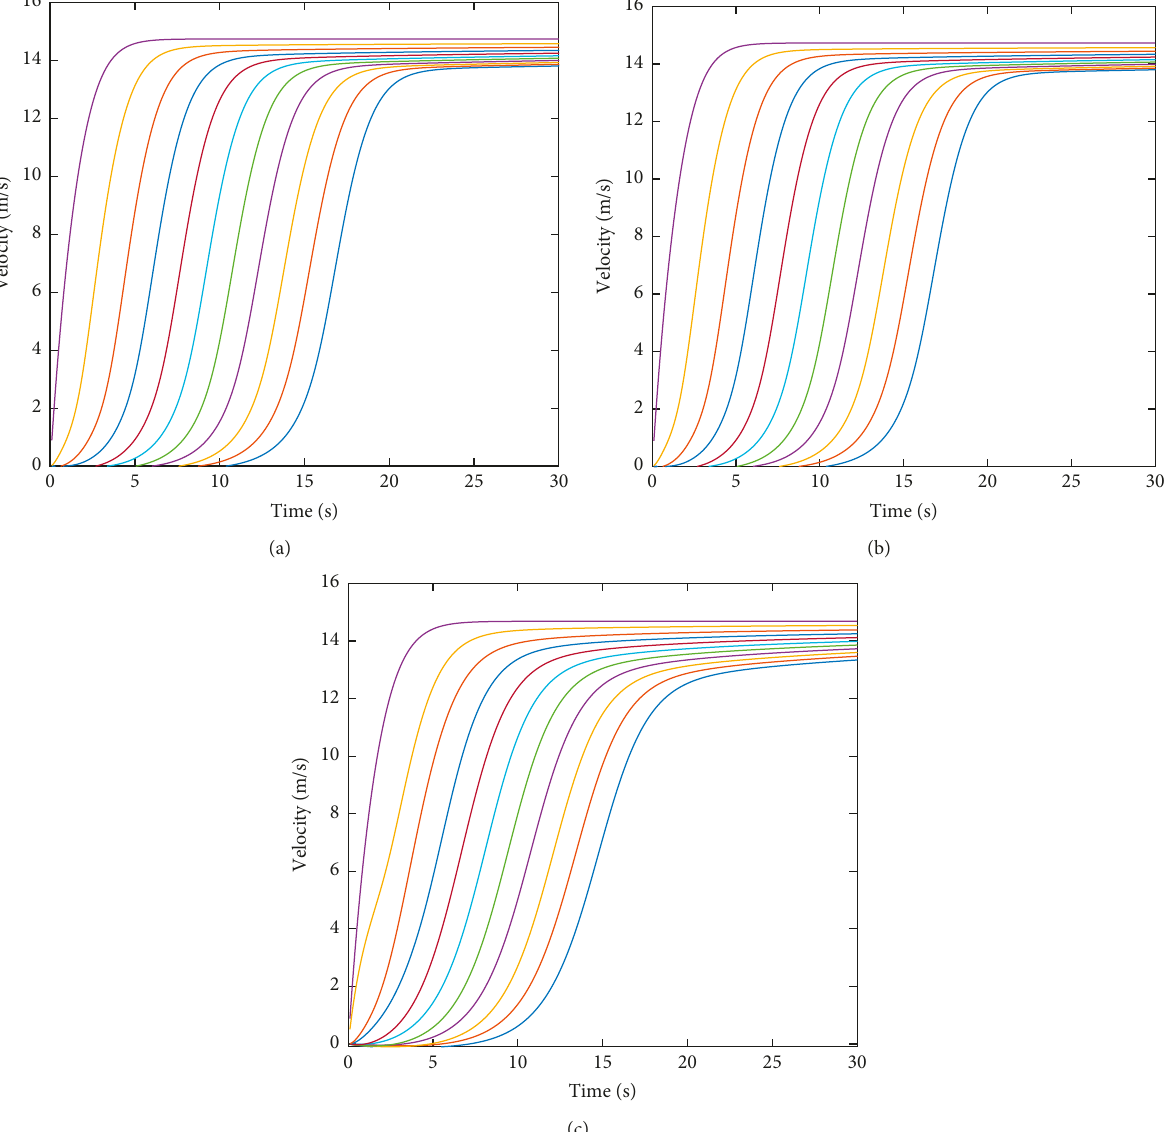
Figure 3: Motion of eleven vehicles during the departure process. (a) FVD model, (b) T